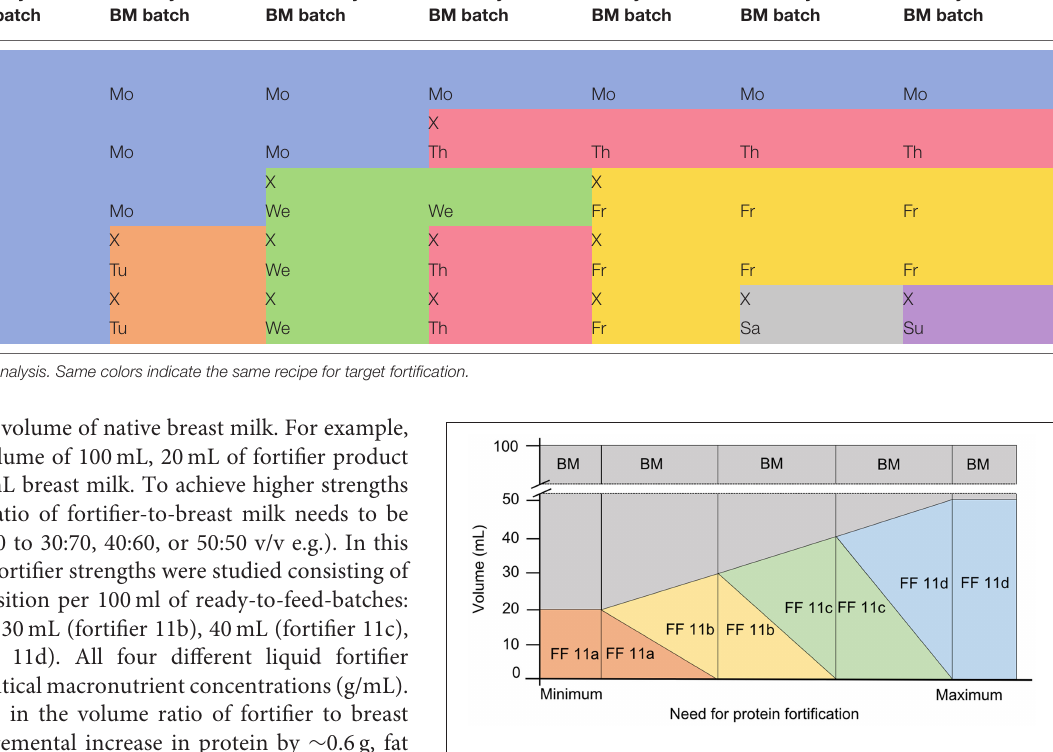
FIGURE 3 | Off-label approach for target fortification with liquid fortifier based on the need of protein fortification in native breast milk (BM, breast milk; FF,